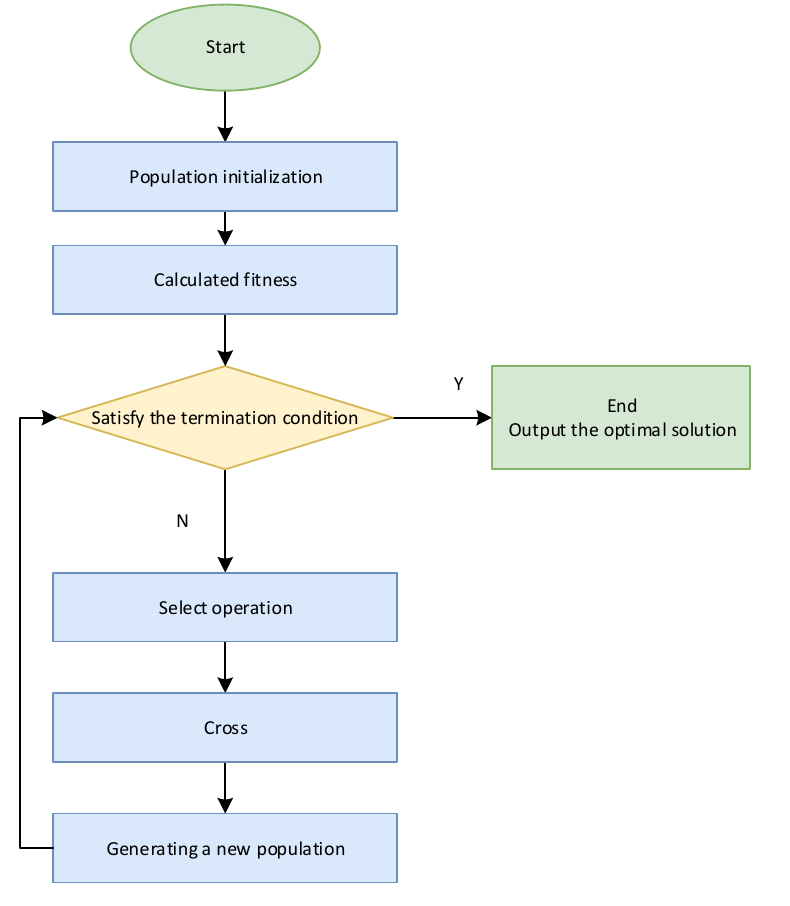
Figure 5. Genetic algorithm flow.